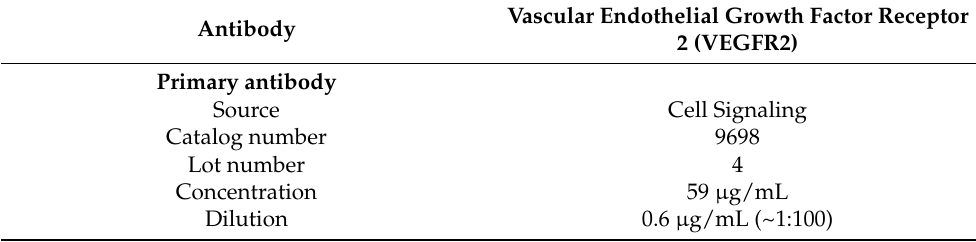
Table 3. Immunohistochemistry assay for toxicology